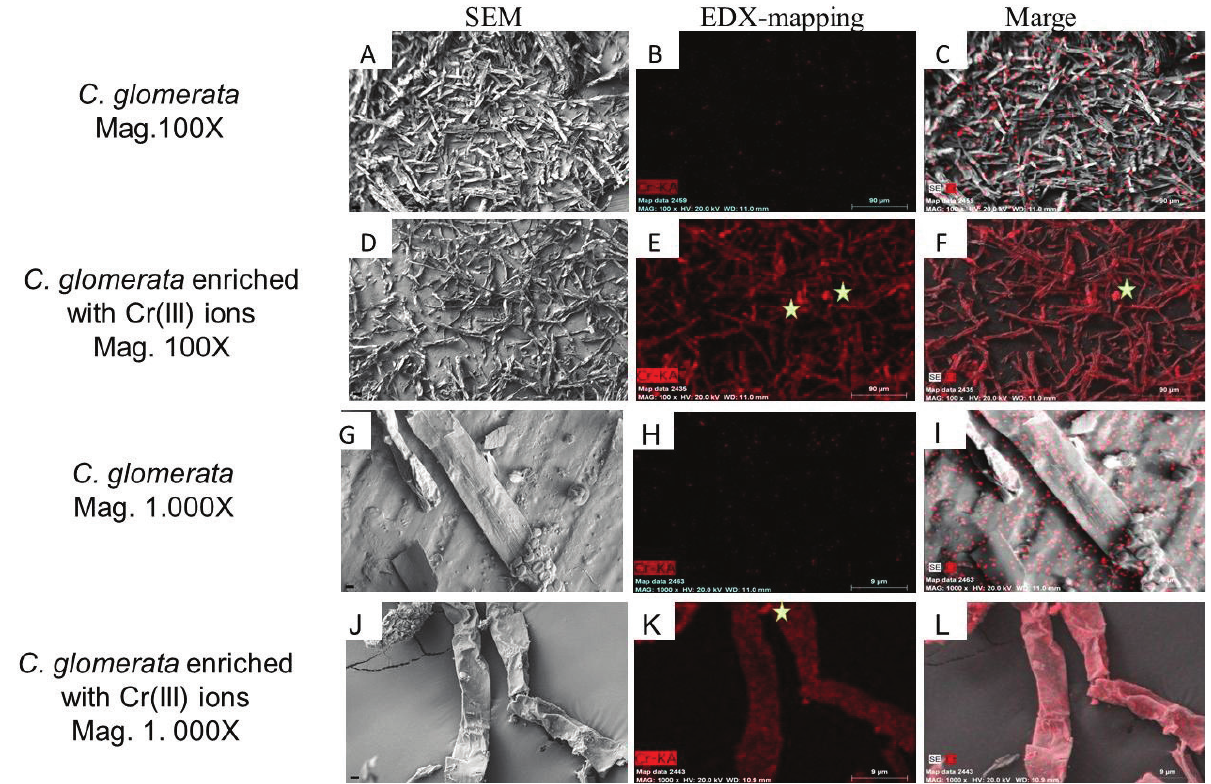
Figure 6: Scanning electron microscope images of native C. glomerata (A, G) and enriched with Cr(III) ions (D, J) performed under the 100X and 1000X magnification, respectively. EDX microphotographs and Cr distribution in native C. glomerata (B, H) and enriched with Cr(III) ions